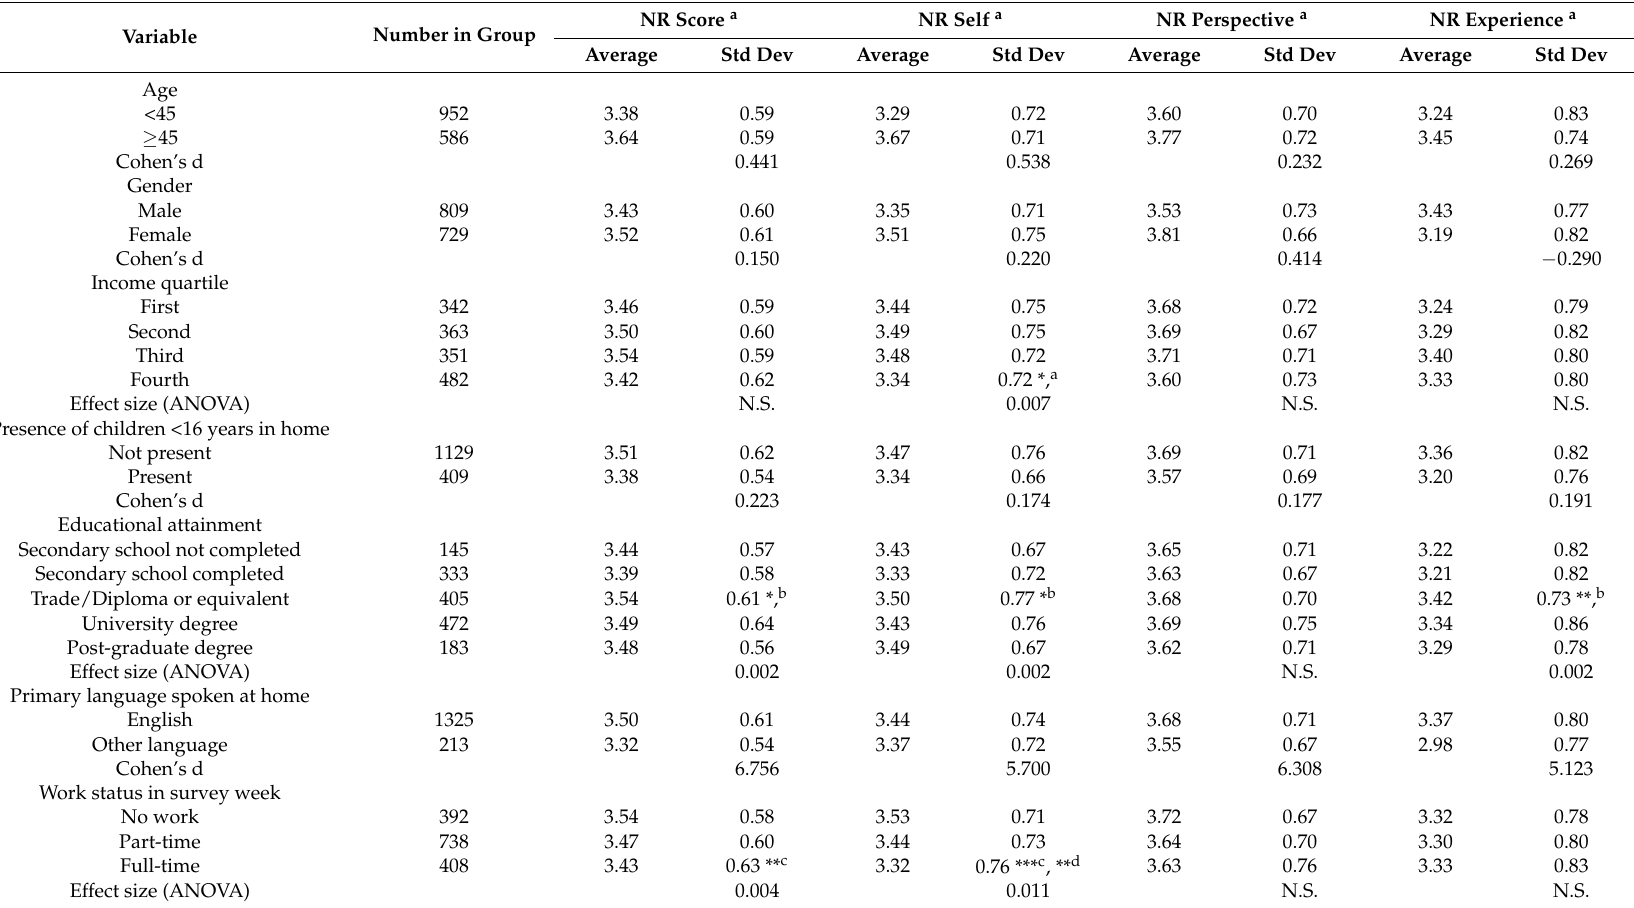
Table 1. Comparing Nature Relatedness across Socio-Demographic